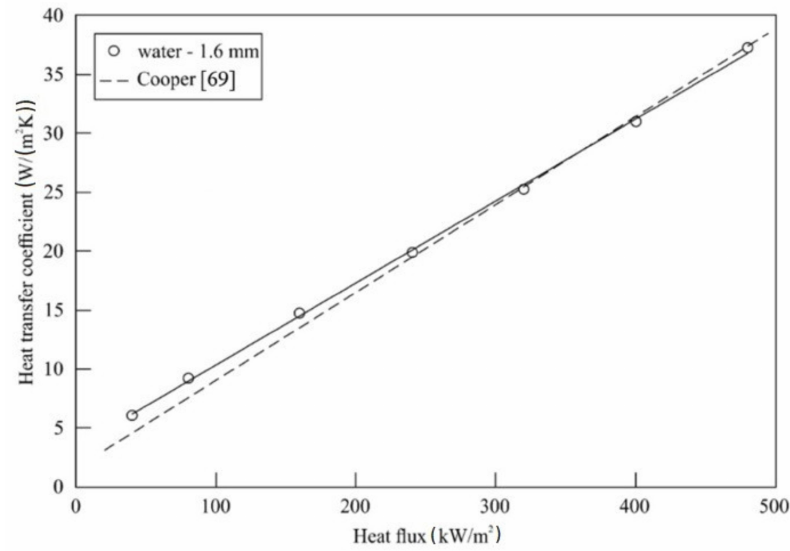
Figure 6. Validation of present experimental results with literature data.